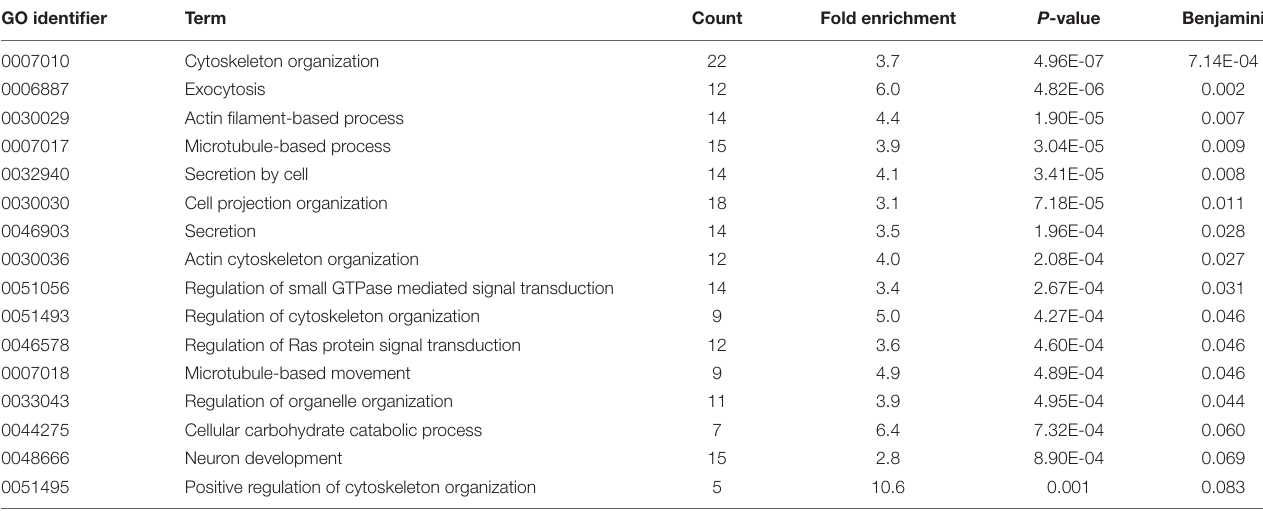
TABLE 2 | Gene ontology (GO) terms associated with the dendritic phagocytic cup fraction. GO identifier Term Count Fold